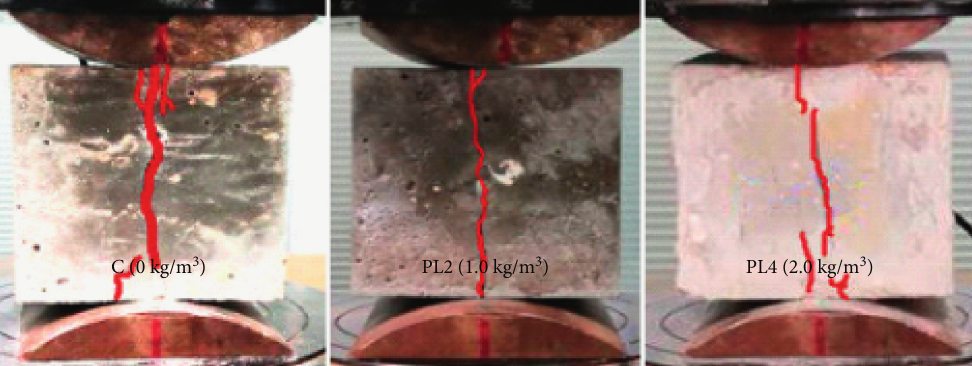
Figure 7: Failure mode of the tension specimen.